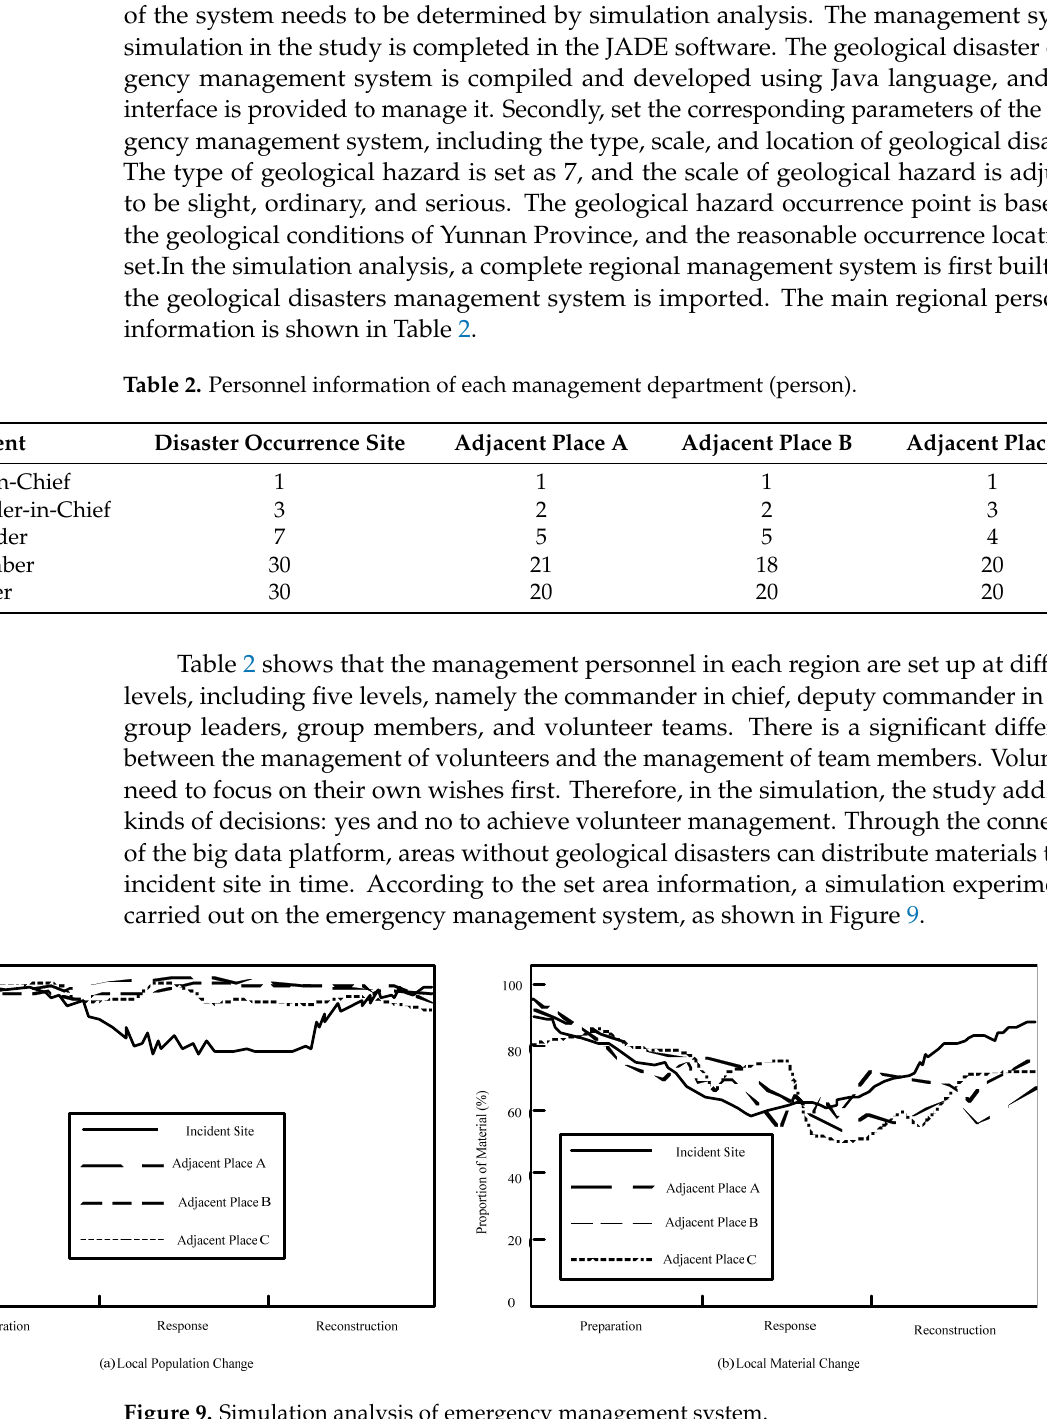
Figure 9. Simulation analysis of emergency management system.